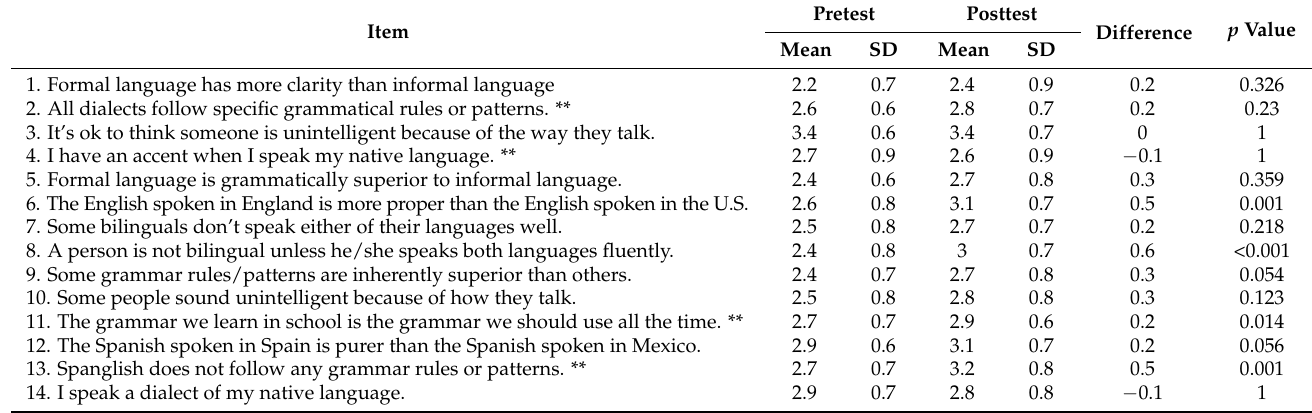
Table 7. Average CLA of 52 undergraduate students averaged across 5 semesters, by construct and for each individual